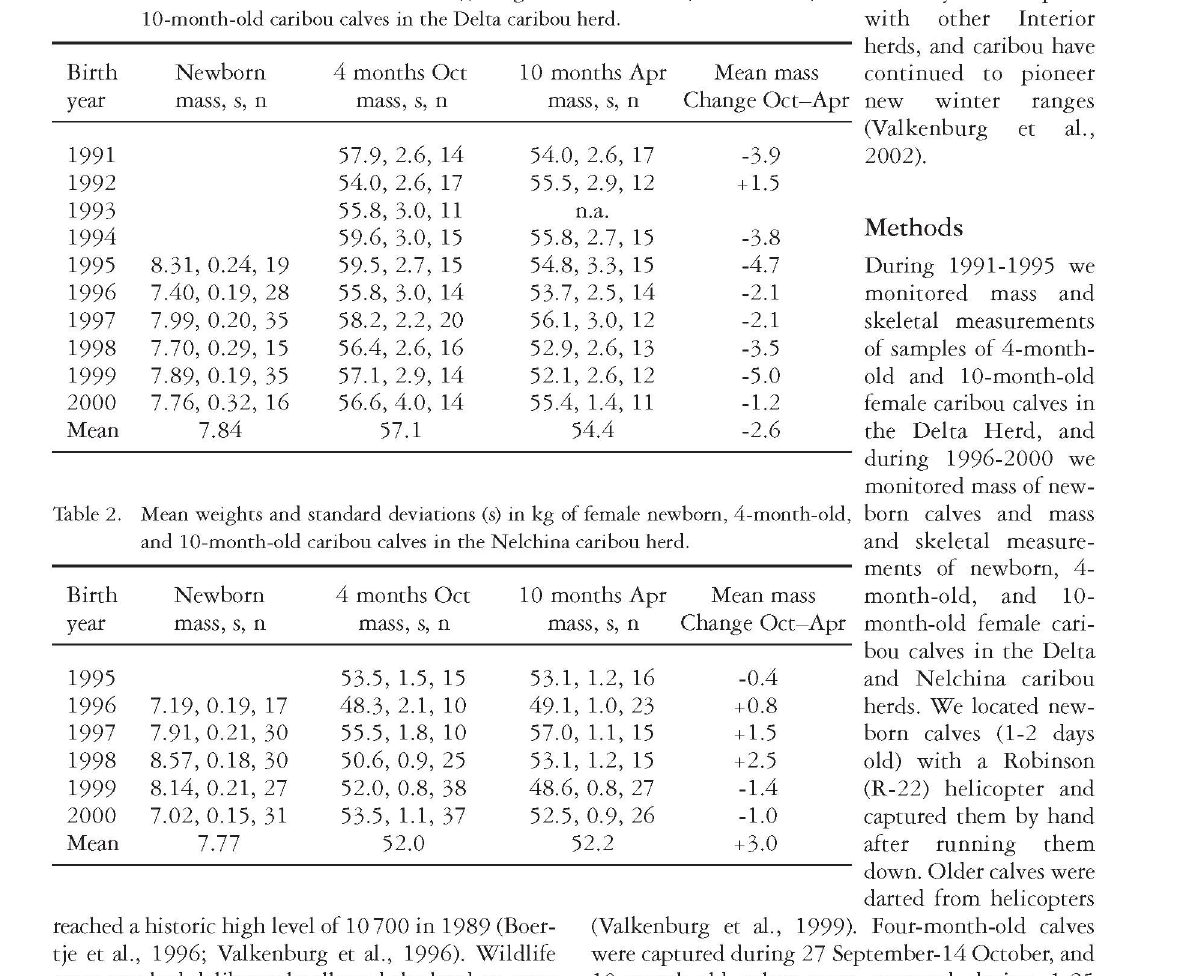
Table 1. Mean mass with standard deviations (s) in kg of female newborn, 4-month-old, and 10-month-old caribou calves in the Delta caribou herd.